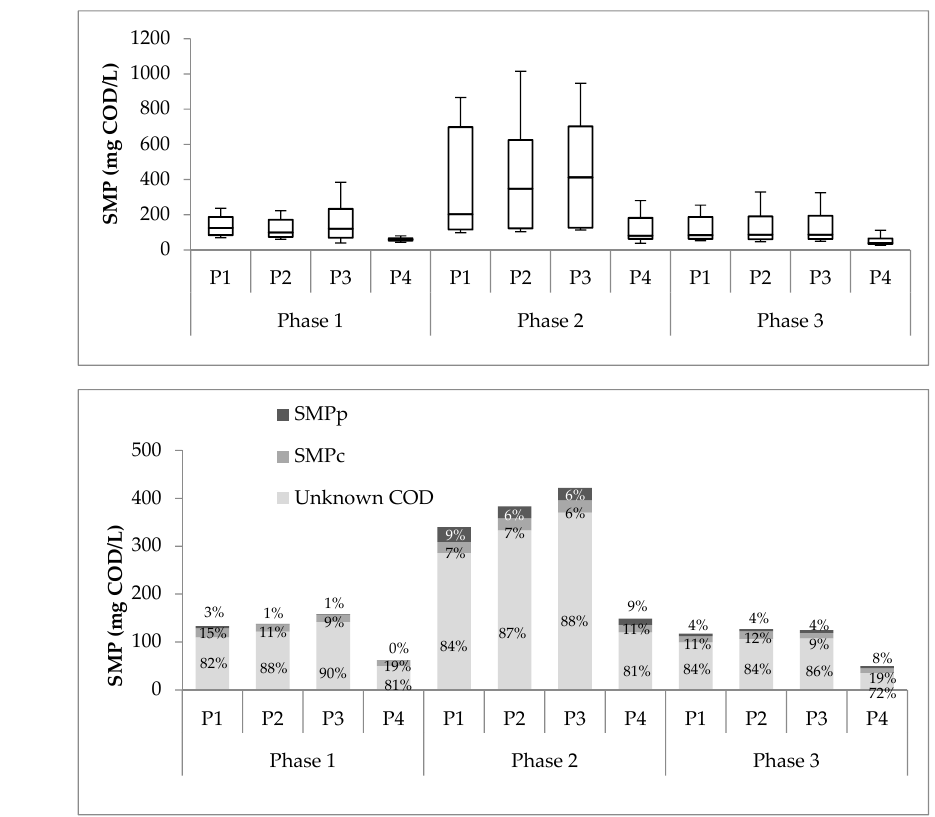
Figure 3. ( a ) SMP concentrations at the four sampling points from all operational phases. ( b ) Average distribution of SMPs into proteins, carbohydrates, and unknown fraction.